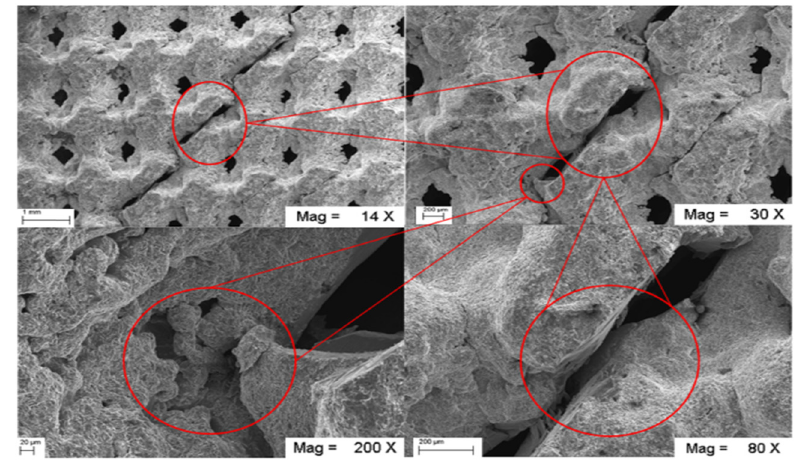
Figure 18: SEM images of fracture morphography under compression.